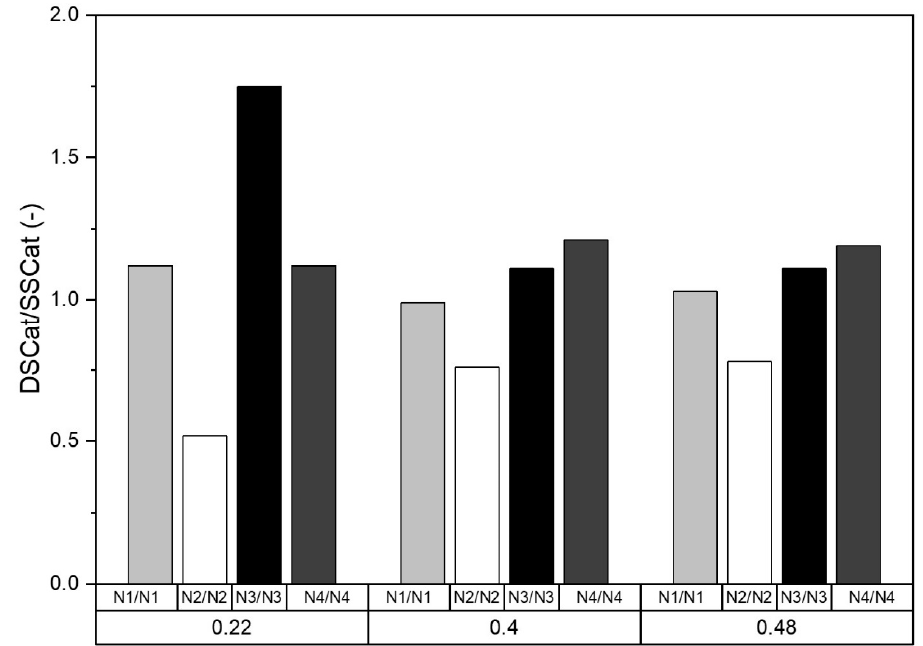
Figure 8. NxDSCat / NxSScat ratio for x = 1 to 4 and for R = 0.22, 0.40, and Figure 8. NxDSCat/NxSScat ratio for x = 1 to 4 and for R = 0.22, 0.40, and 0.48.